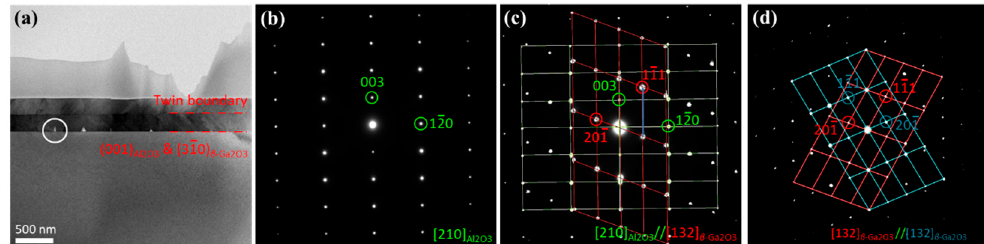
Figure 5. ( a ) ABF image showing the general structural feature of the thin film after annealing. ( b ) EDPs of Al 2 O 3 substrate along [210] zone-axis. ( c ) Composite EDPs of [210] Al2O3 and [132] β -Ga2O3 taken from the interface. ( d ) EDPs of the twins within the β -Ga 2 O 3 (a-d) were obtained from the thin films after annealing. Circled area in ( a ) indicates the hole along the interface.